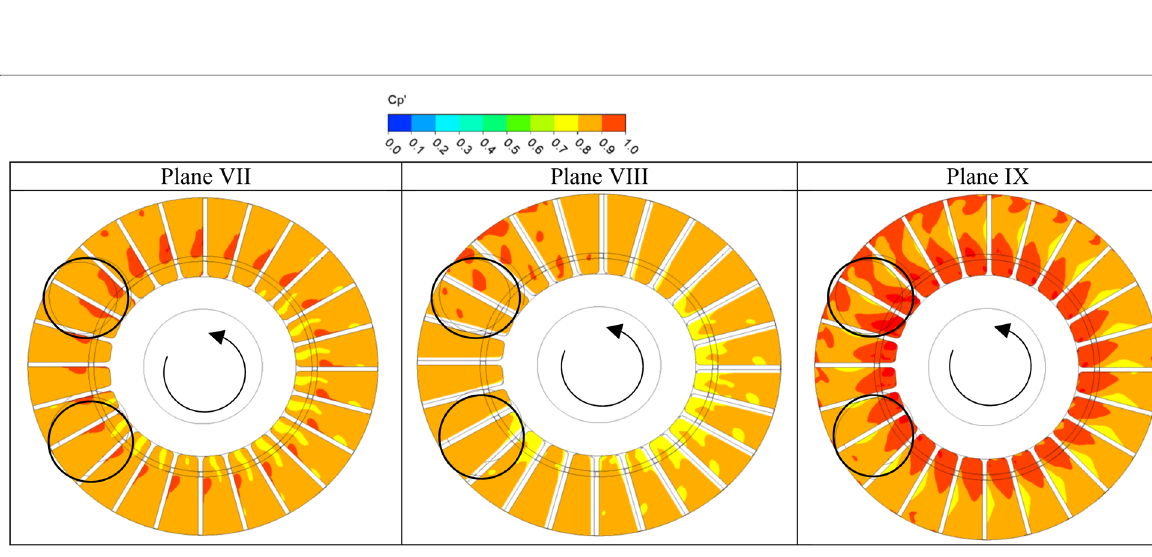
Figure 20 Distributions of pressure pulsation intensity coefficients on axial